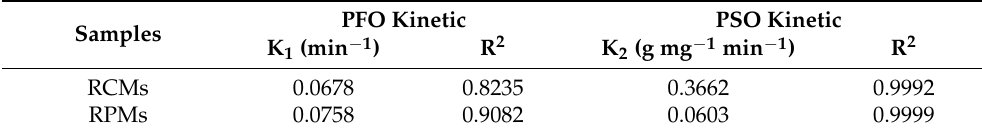
Table 1. Kinetic data of PFO kinetic model and PSO kinetic model.